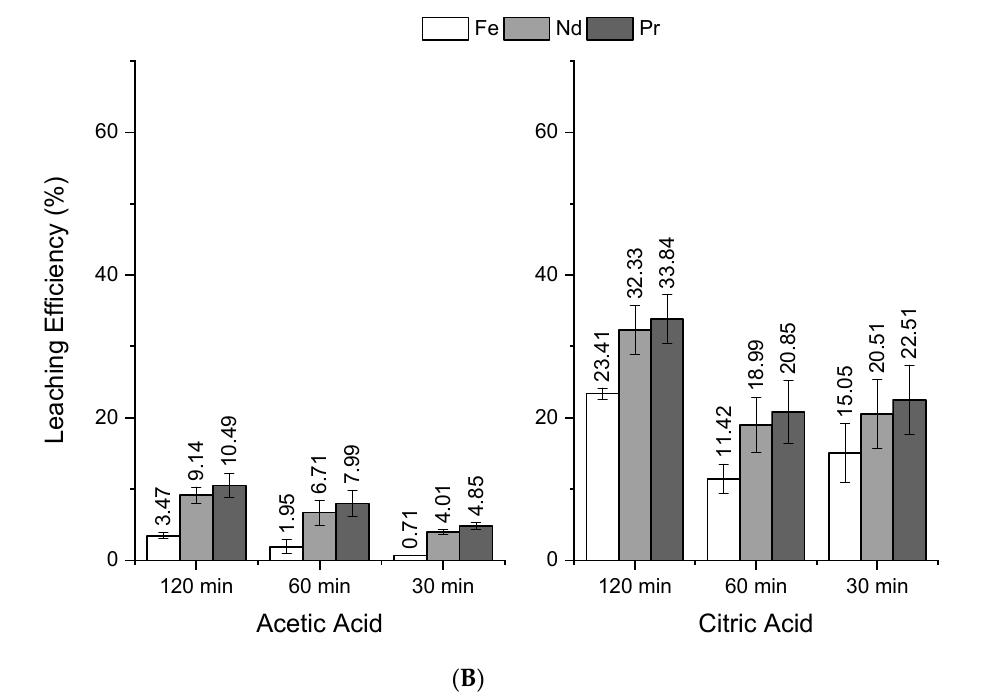
Figure 7. Comparison of the leaching efficiency of NdFeB magnets in acetic and citric acids, concen- tration 0.5 M, ratio s/l ( A ) 1/100 and ( B ) 1/50.